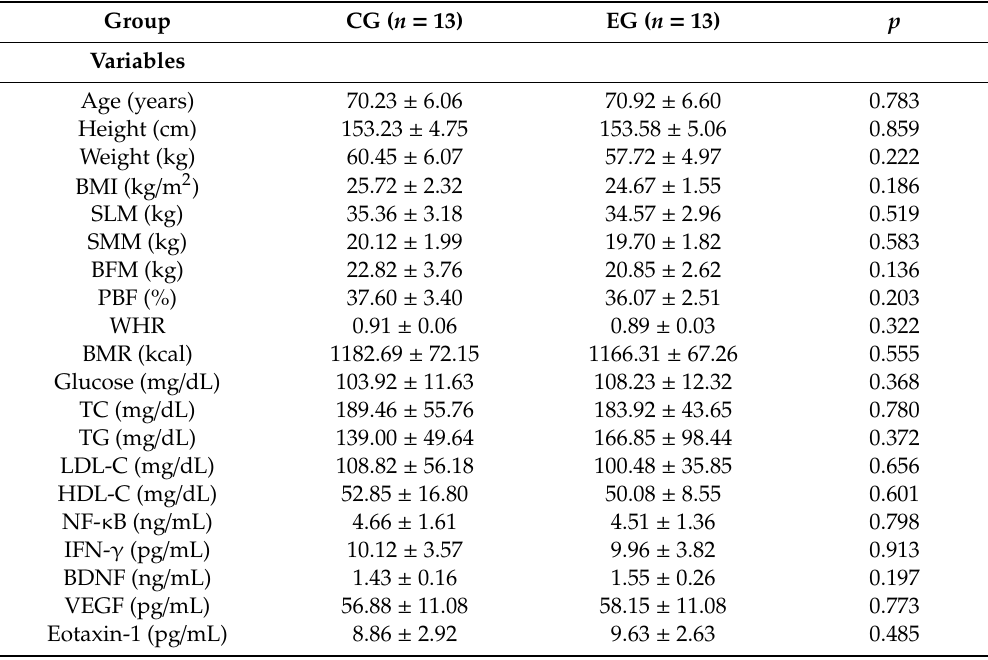
Table 1. The characteristics of the participants at